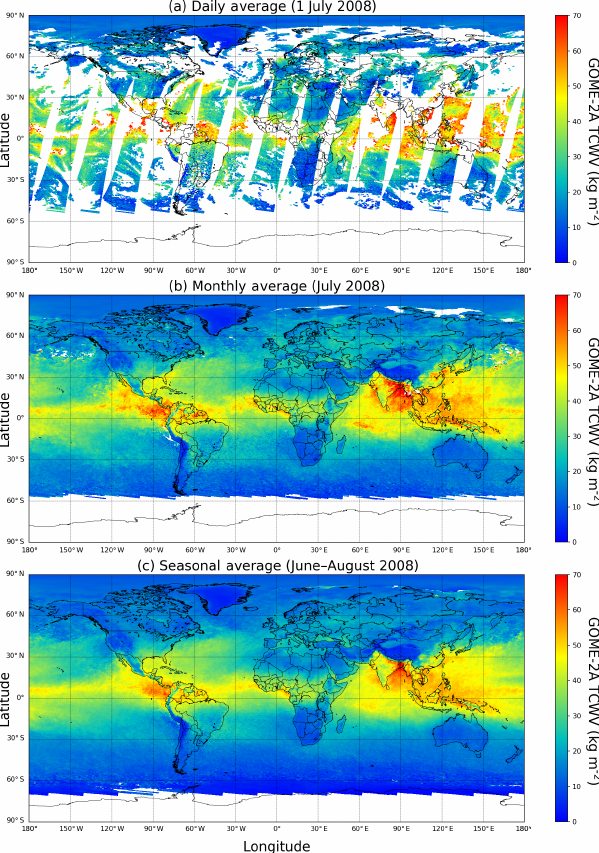
Figure 6. (a) Daily (1 July 2008), (b) monthly (July 2008) and (c) seasonal (June–August 2008) average of GOME-2A observa- tions of